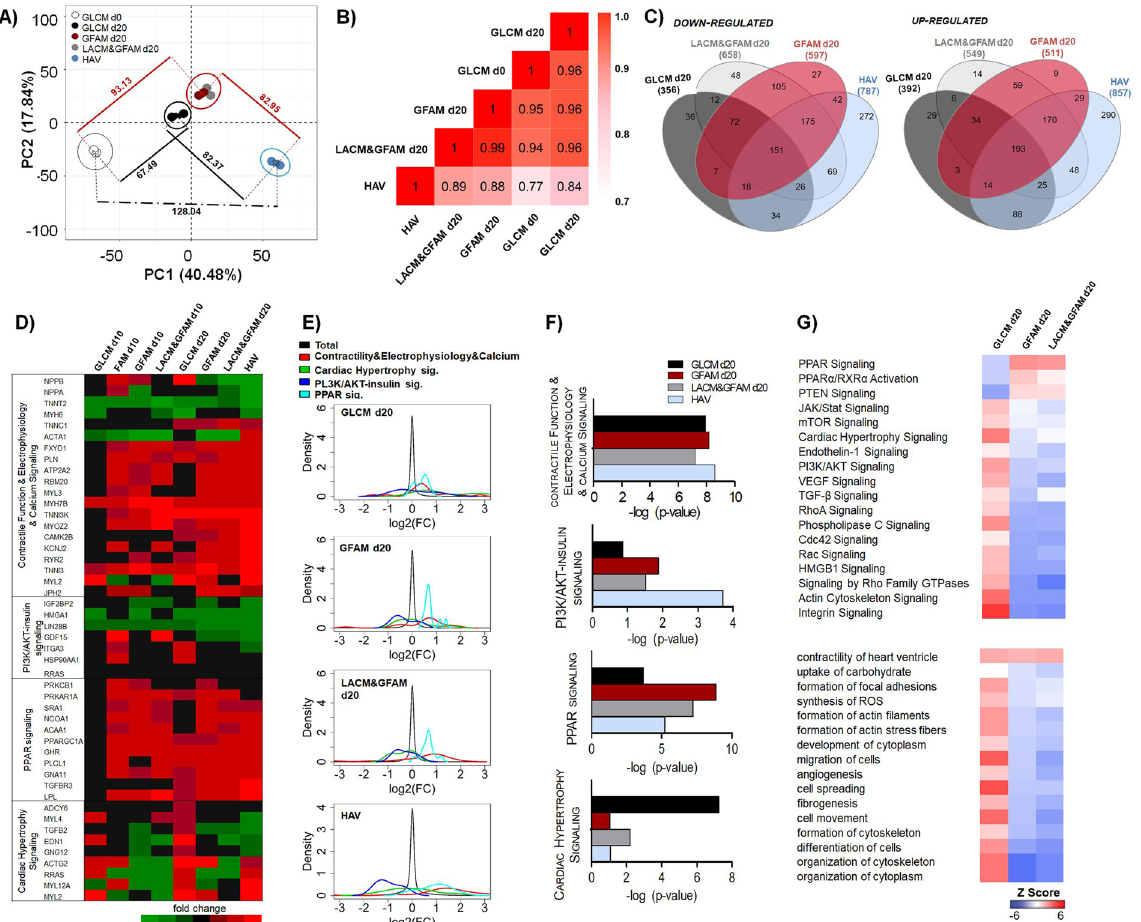
Figure 4. Effect of culture medium composition on hiPSC-CM transcriptional profiling. ( A ) 2D principal component analysis of all genes significantly enriched (p < 0.01) in hiPSC-CM cultures at day 0, after 20 days of culture in GLCM, GFAM and LACM&GFAM and HAV tissue samples. Euclidean distances between PCA centroids of each condition, calculated considering PC1 and PC2, are also highlighted. ( B ) Pairwise Pearson correlation coefficients using expression data of all enriched genes (p < 0.01). ( C ) Venn diagrams of overlapping differentially-expressed genes (p < 0.01 and FC ≥ |1.3|) among GLCM, GFAM, LACM&GFAM cultures at day 20 and HAV tissue. ( D ) Heatmap depicting changes in the expression of genes involved in biological processes/pathways closely associated with CM development and function. ( E – F ) Density plots generated with fold change expression of genes from the four cardiac-related categories shown in ( D ), for day 20 cultures (GLCM, GFAM and LACM&GFAM). Black line indicates expression of all genes. Colored lines toward the left and right side of the black line indicate down-regulation and up-regulation of pathways, respectively. Kolmogorov-Smirnov test was used to calculate p-values. ( G ) Heatmaps highlighting the activation status of canonical pathways (upper panel) and biological functions (lower panel) predicted by IPA. Functions/pathways were considered significantly activated (or inhibited) with an overlap p-value ≤ 0.05 and an IPA activation Z-score ≥ |2.0|. Red indicates positive Z-score (activated function) and blue indicates negative Z-score (inhibited